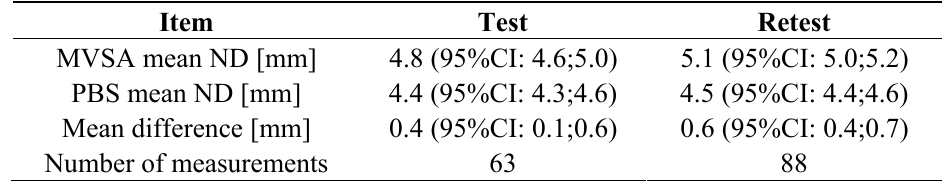
Table 4. Mean values based on the measurements from the MVSA system and the PBS system, respectively. The test person has a normal navicular drop